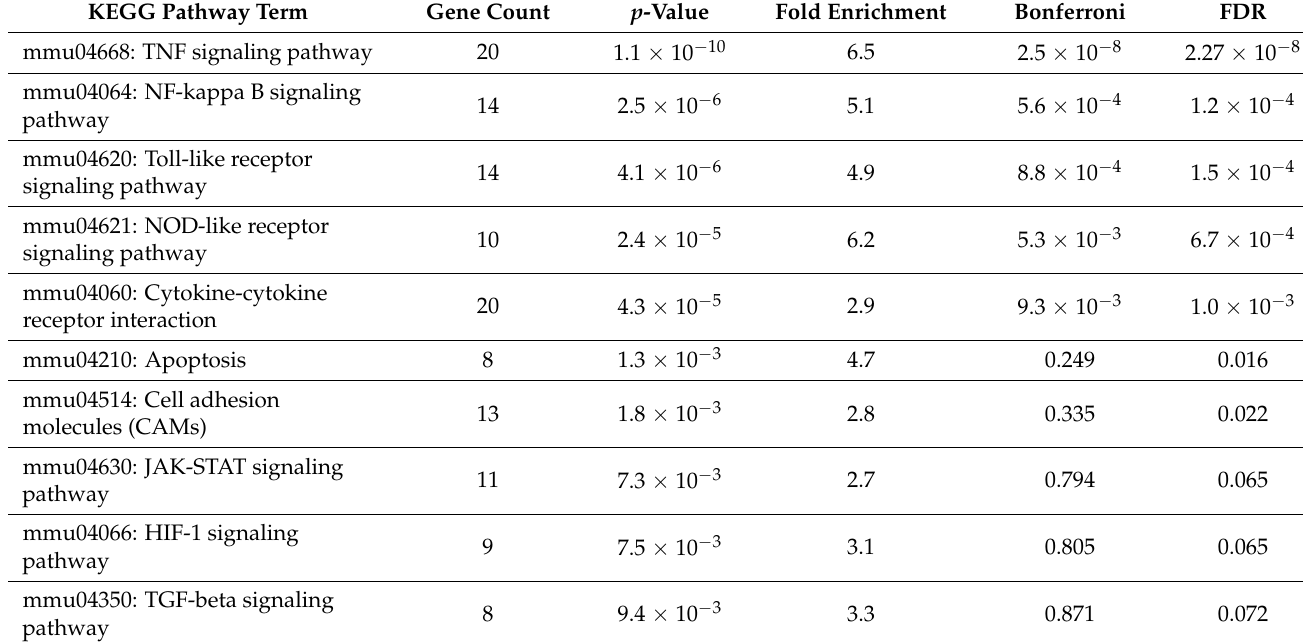
Table 2. Top inflammation-related enriched KEGG pathways using top 500 DEGs from